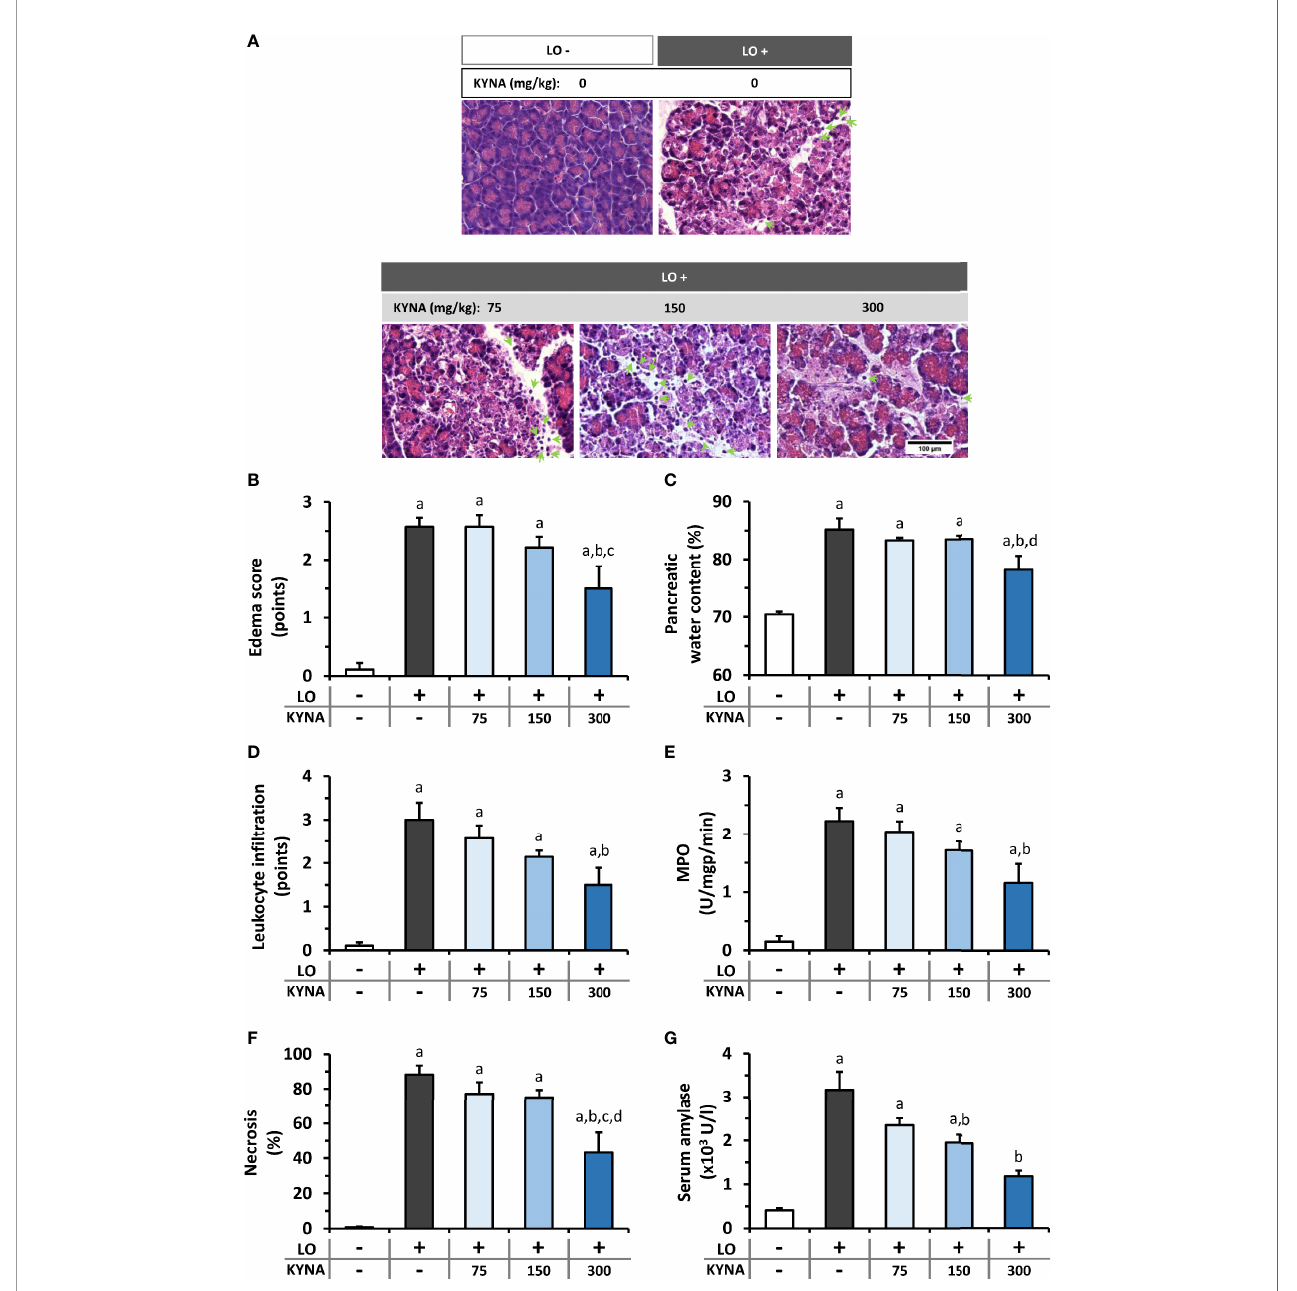
FIGURE 2 | The effects of kynurenic acid (KYNA) on the severity of acute pancreatitis (AP). (A) Representative histopathological images of pancreatic tissues of the treatment groups, arrows indicate neutrophil granulocytes. Bar charts show the extent of pancreatic (B) edema, (C) water content, (D) leukocyte in fi ltration, (E) myeloperoxidase (MPO) activity, (F) necrosis, and (G) serum amylase activity measurements. Values represent means with standard error, n=5-14. One-way ANOVA was performed followed by Holm-Sidak post-hoc test. Statistically signi fi cant differences (p<0.05) were marked with: (a) vs . control; (b) vs . LO; (c) vs . LO+75 mg/kg KYNA; (d) vs . LO+150 mg/kg KYNA. AP, acute pancreatitis; KYNA, kynurenic acid; LO, L-ornithine-HCl; MPO,